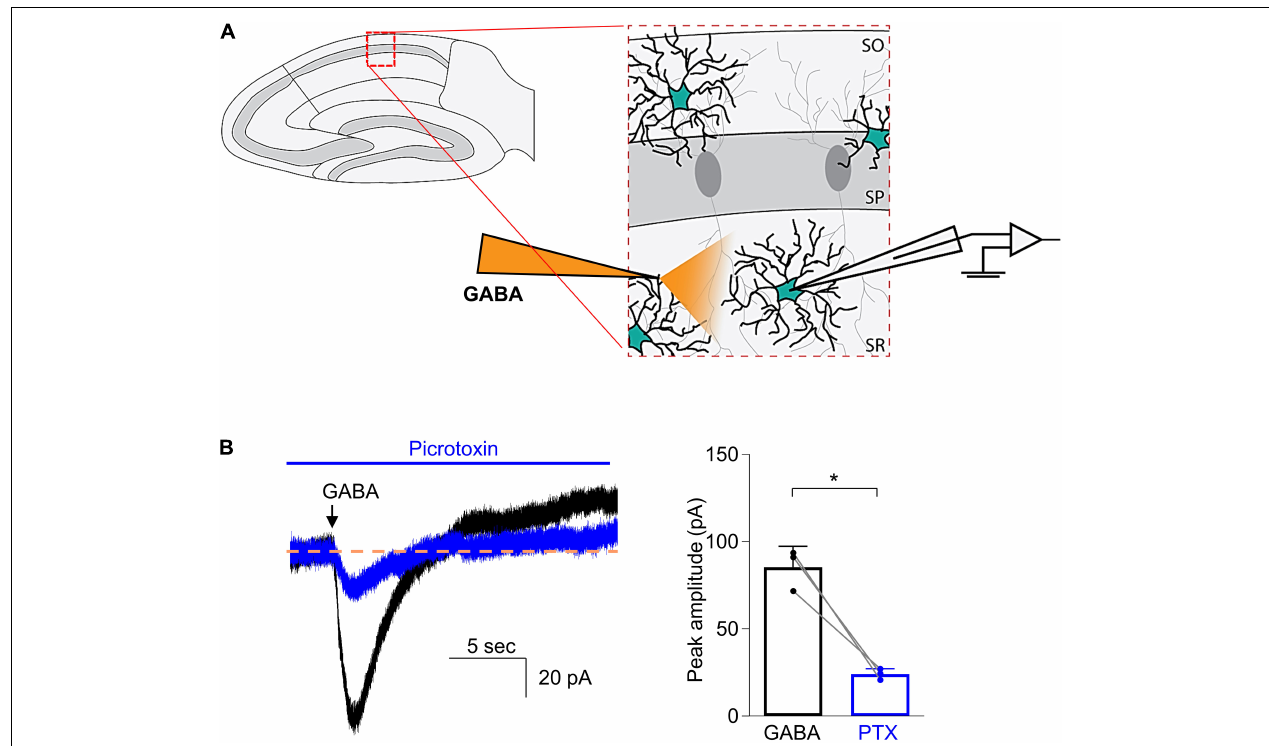
FIGURE 2 | Focal puff application of GABA to astrocytes induced an inward current that was inhibited by picrotoxin. (A) Schematic drawing shows that a glass capillary containing GABA (300 µ M) was placed 50–100 µ m away from the recorded astrocyte in the stratum radiatum of CA1 region of a hippocampal slice. (B) Left: Representative traces demonstrate current responses to puff applications of GABA before (black) and during addition of picrotoxin (0.5 mM, blue), a non-competitive GABA A receptor antagonist. Right: Quantified data show the inhibitory effects of picrotoxin (PTX). n = 3, * P = 0.019, paired Student’s t -test. Data are presented as mean ±